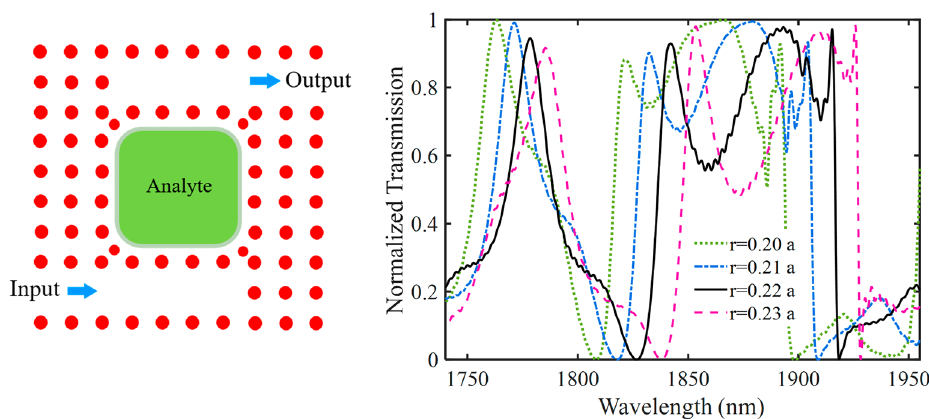
Figure 7. The effect of the radius of Si PhC rods ( r ) on the transmission spectrum of the PhC sensor without metallic